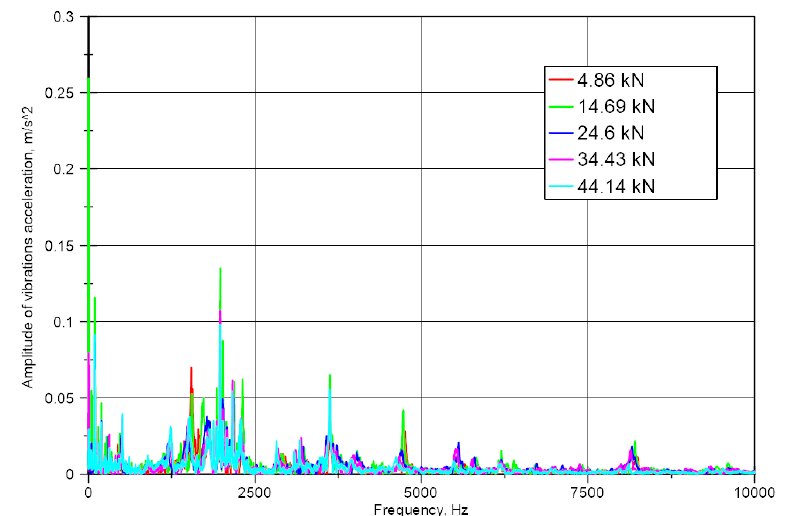
Figure 12. Dependence of the resonance frequency for different sample load determined by SAS using a piezoelectric